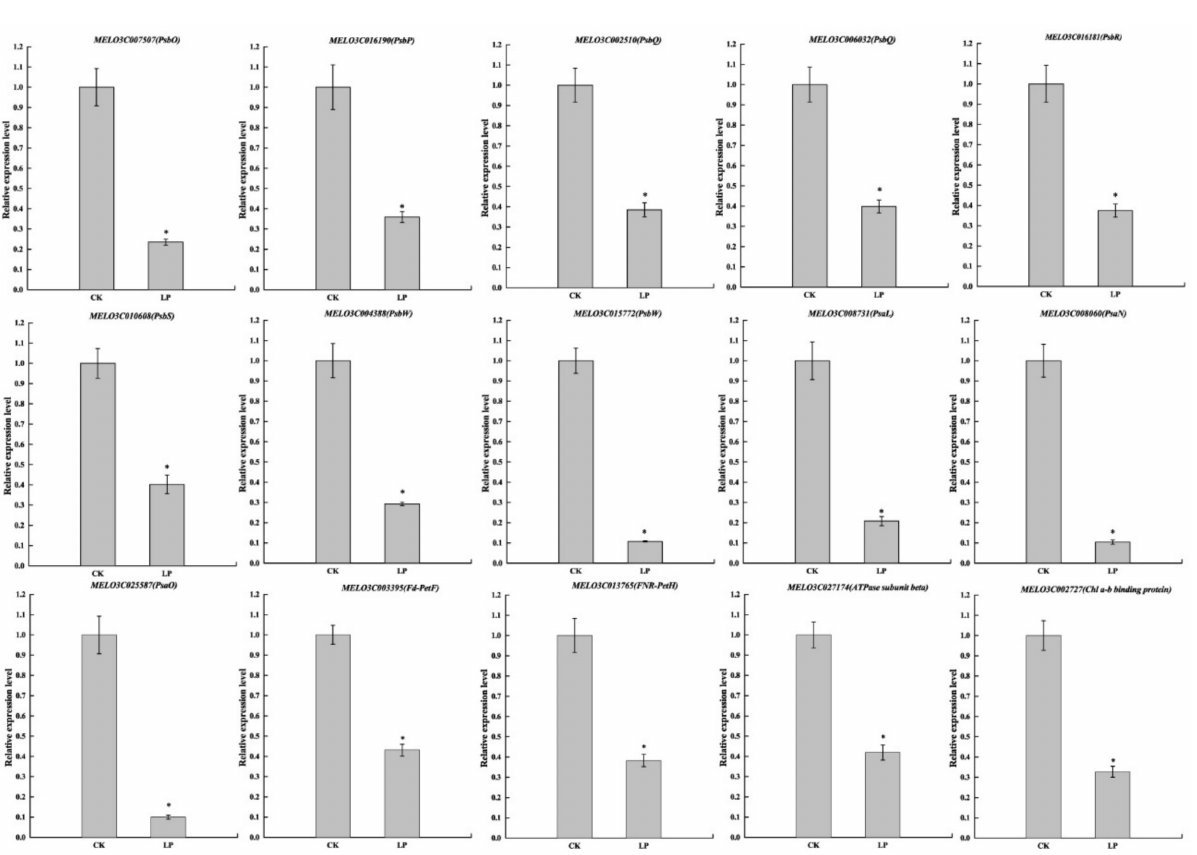
Figure 10. qRT-PCR validation of the selected DEGs. The error bars indicate SD ( n = 6). The asterisks indicate the significant differences according to Tukey’s test with one-way ANOVA (* p <